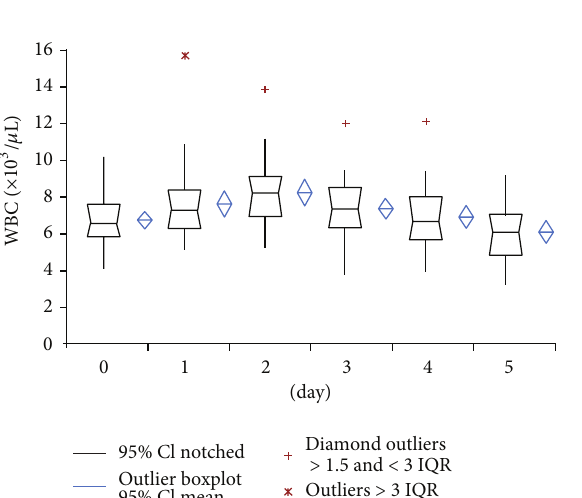
Figure 1: Course of CRP serum levels.